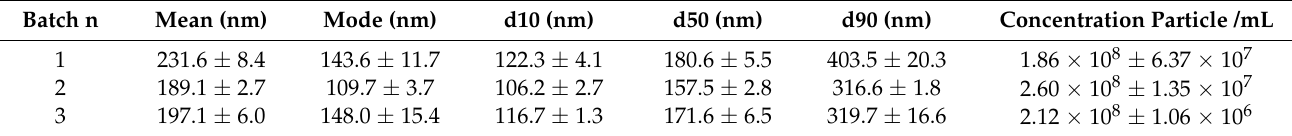
Table 9. Particle size distribution and concentration of batch 1, 2 3 (mean values ± standard deviation, n = 3). Batch n Mean